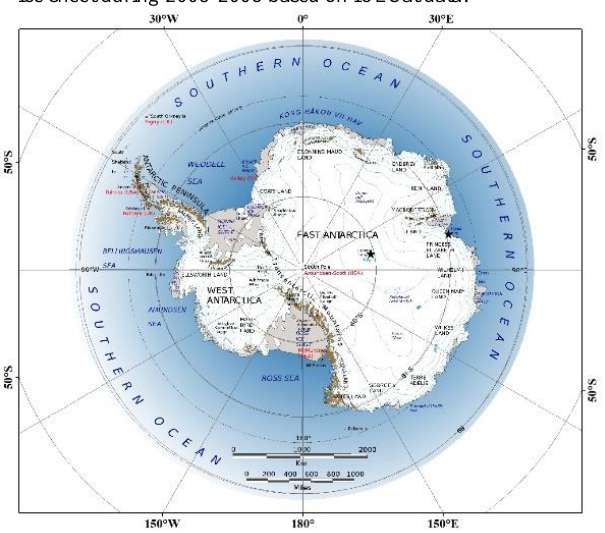
Figure 1. The Antarctic ice sheet overview map, the background image is adapted from the Landsat Image Mosaic of Antarctica (Bindschadler et al.,